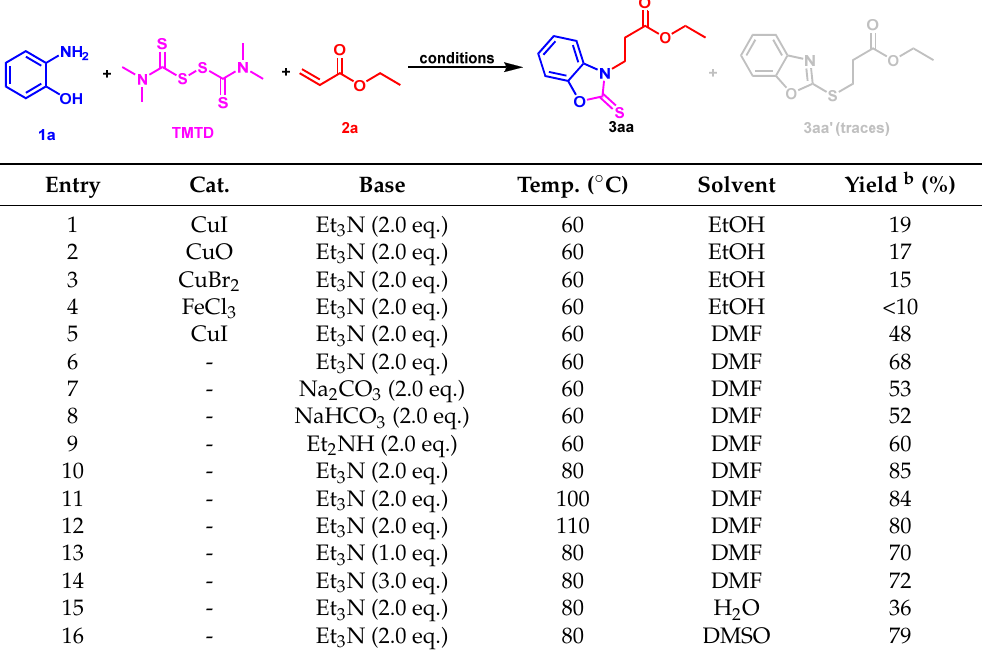
Table 3. One-pot synthesis of benzothiazole-substituted ester compounds a,b .